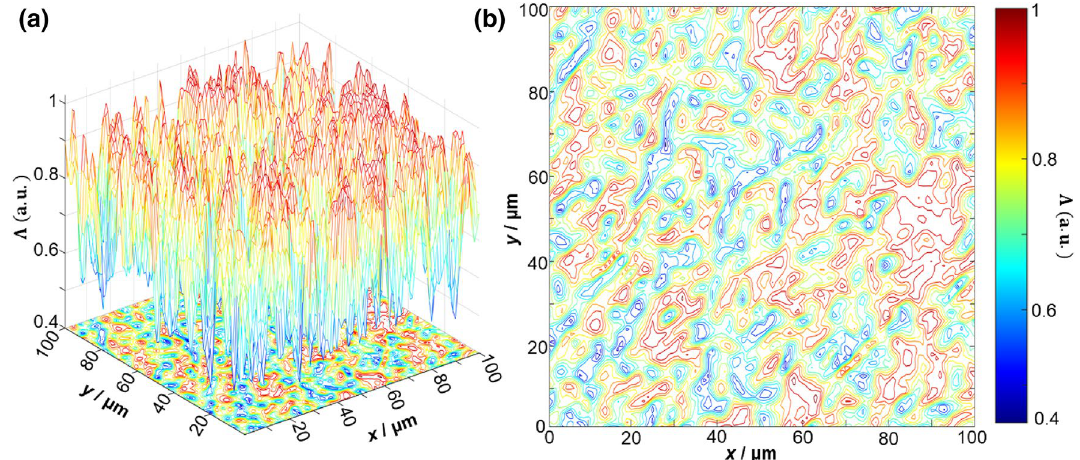
x , y , θ k = 0.85 rad of a sample of a (cid:30) (cid:31)